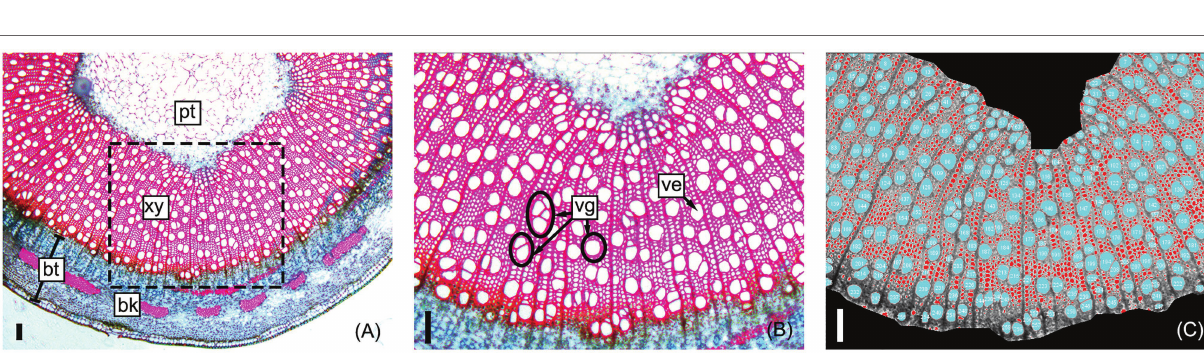
FIGURE 2 | Representative sample of a poplar stem cross-section used to obtain stem and vessel anatomical trait data. Section micrographs include the pith (pt), secondary xylem (xy), and bark (bk); bark thickness (bt) is measured before image processing (A) . Vessel elements (ve) and vessel group (vg) examples are shown within a close-up of the sampled section (B) ; vessel groups are single vessels or any number of clustered vessels with secondary cell walls that are in contact. Image J software (v2) was used to measure xylem area, automatically count vessels, and measure vessel areas and circularities (see section “Materials and Methods”) within the secondary xylem (C) . All scale bars are 100 μ